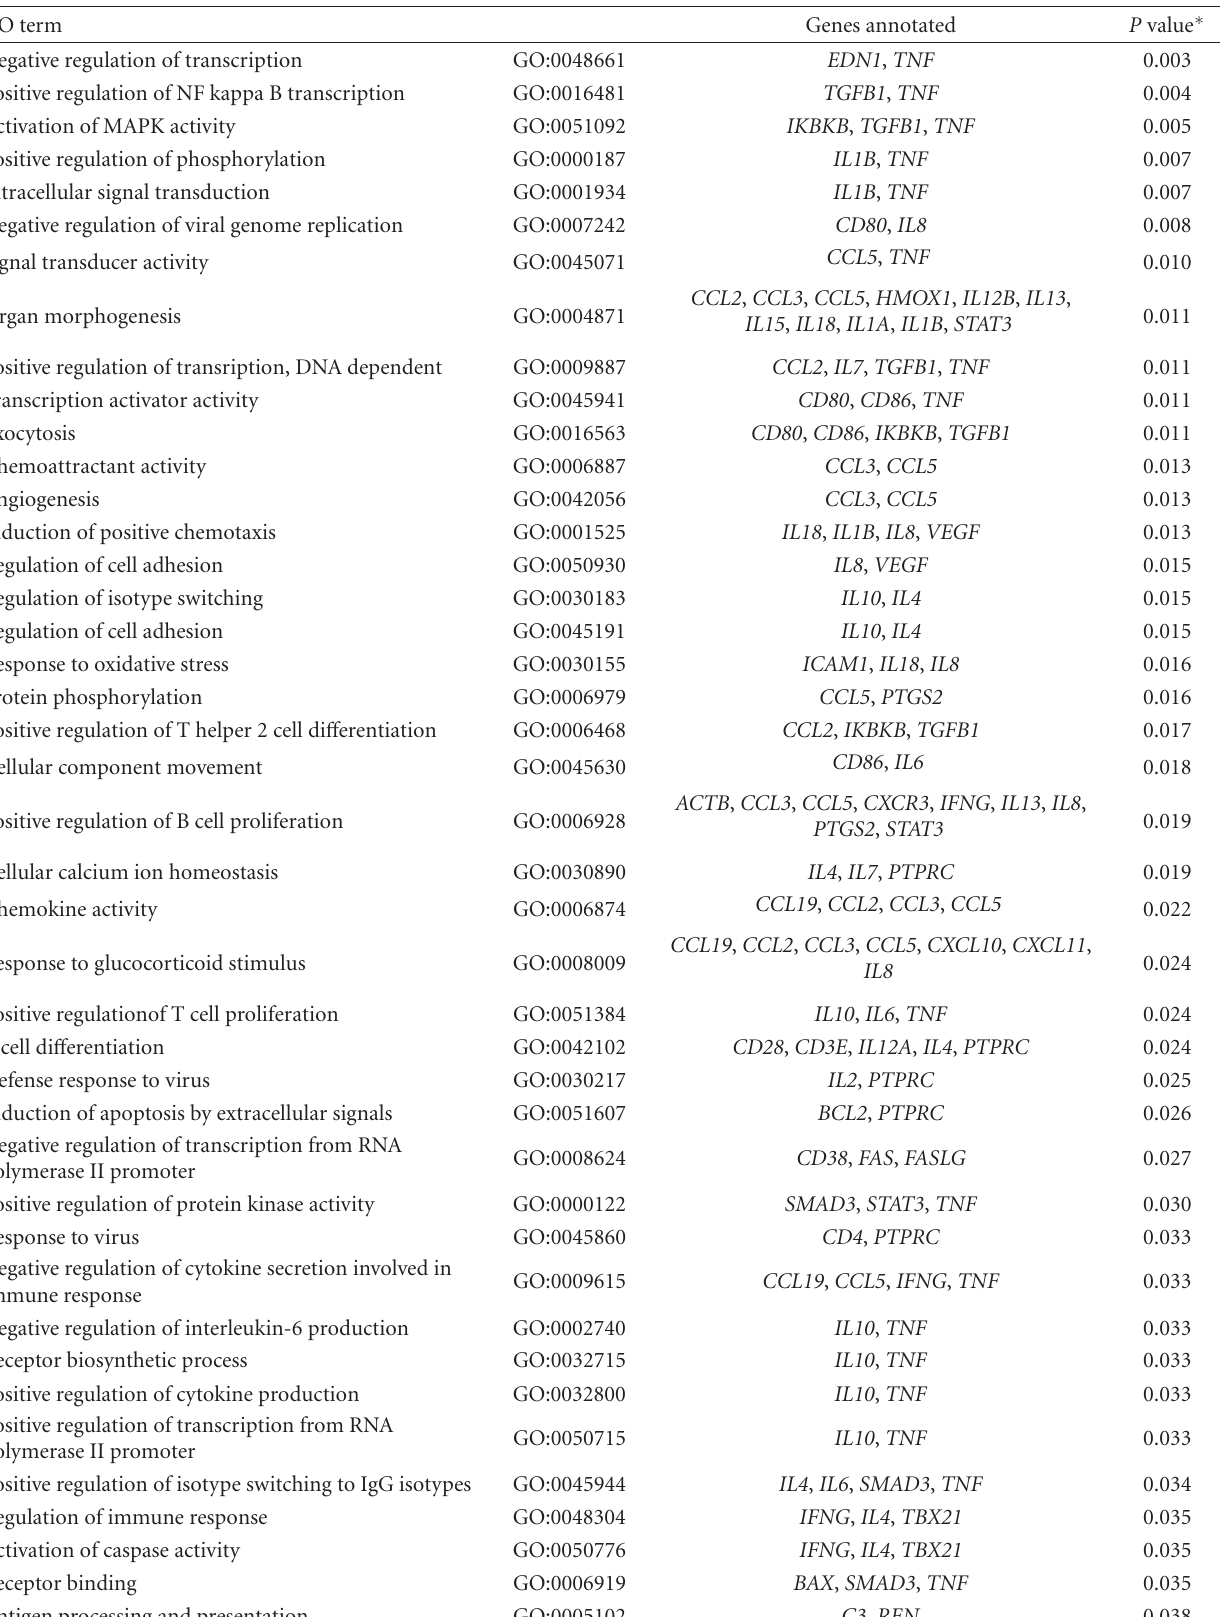
Table 5: Biological networks in kidney graft tissues that are associated with